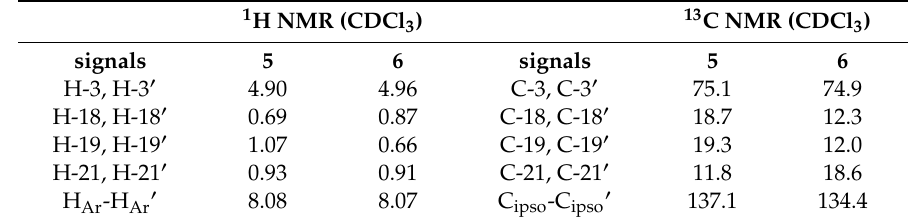
Figure 2. 1 H - NMR spectrum at 500 MHz of bicholesterol ester ( 5 ) in CDCl 3 . Figure 2. 1 H-NMR spectrum at 500 MHz of bicholesterol ester ( 5 ) in CDCl 3 . Table 2. Selected 1 H and 13 C NMR signals for compounds 5 and 6 , in Table 2. Selected 1 H and 13 C NMR signals for compounds 5 and 6 , in ppm.